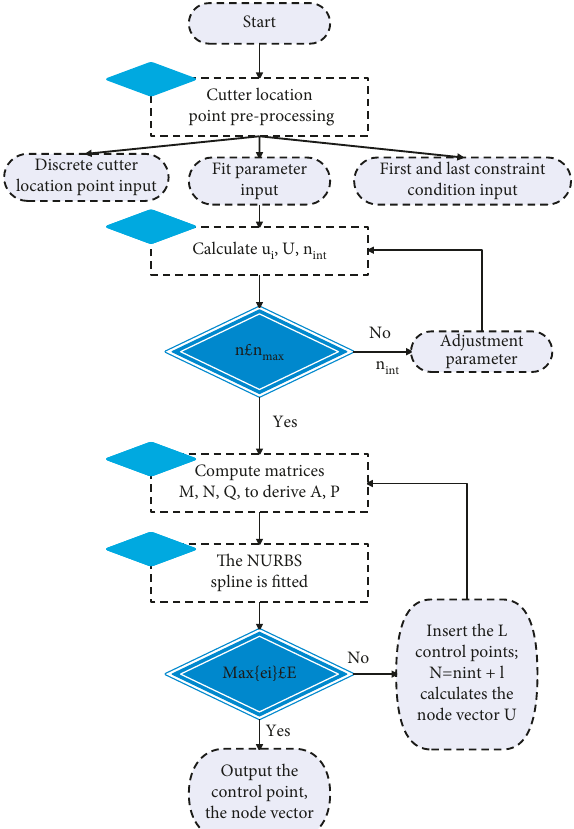
Figure 3: NURBS curve fitting process for constraints.